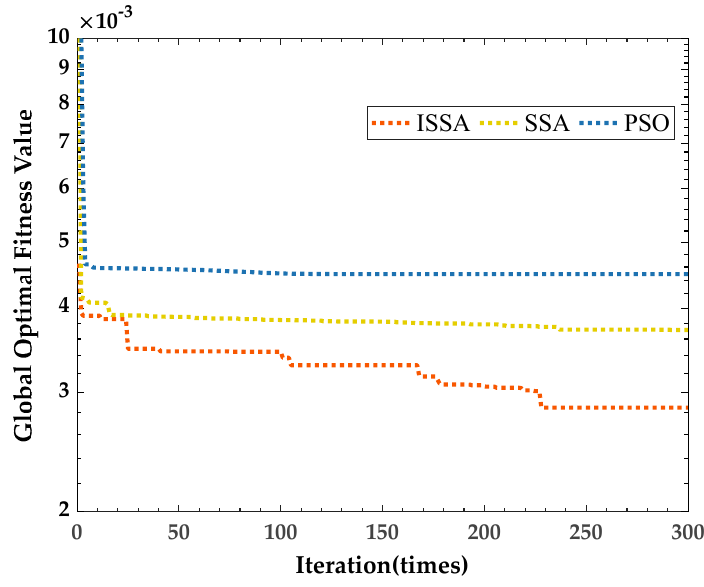
Figure 9. Fitness curves of ISSA, SSA, and PSO algorithms.